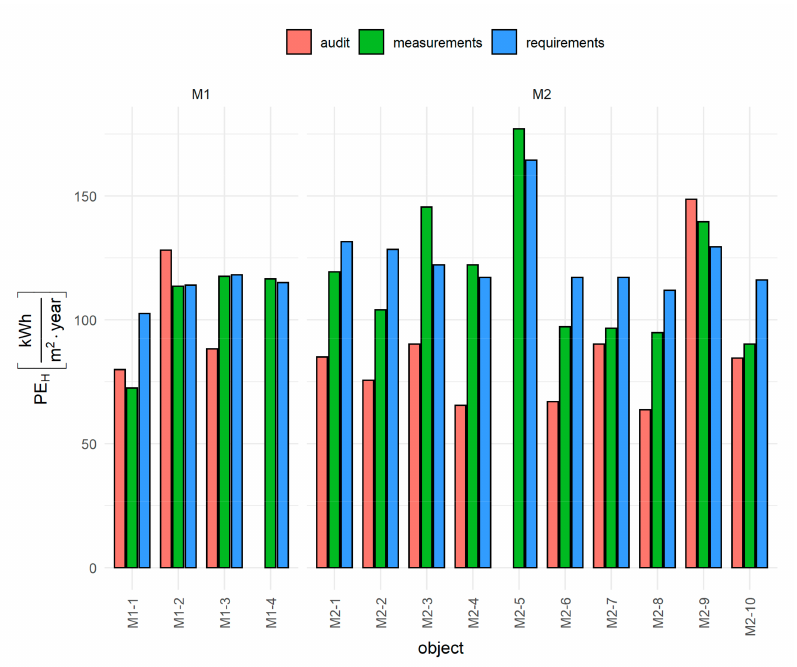
Figure 5. Comparison of the obtained PE H index values with those calculated in the audit after thermal refurbishment and with the technical